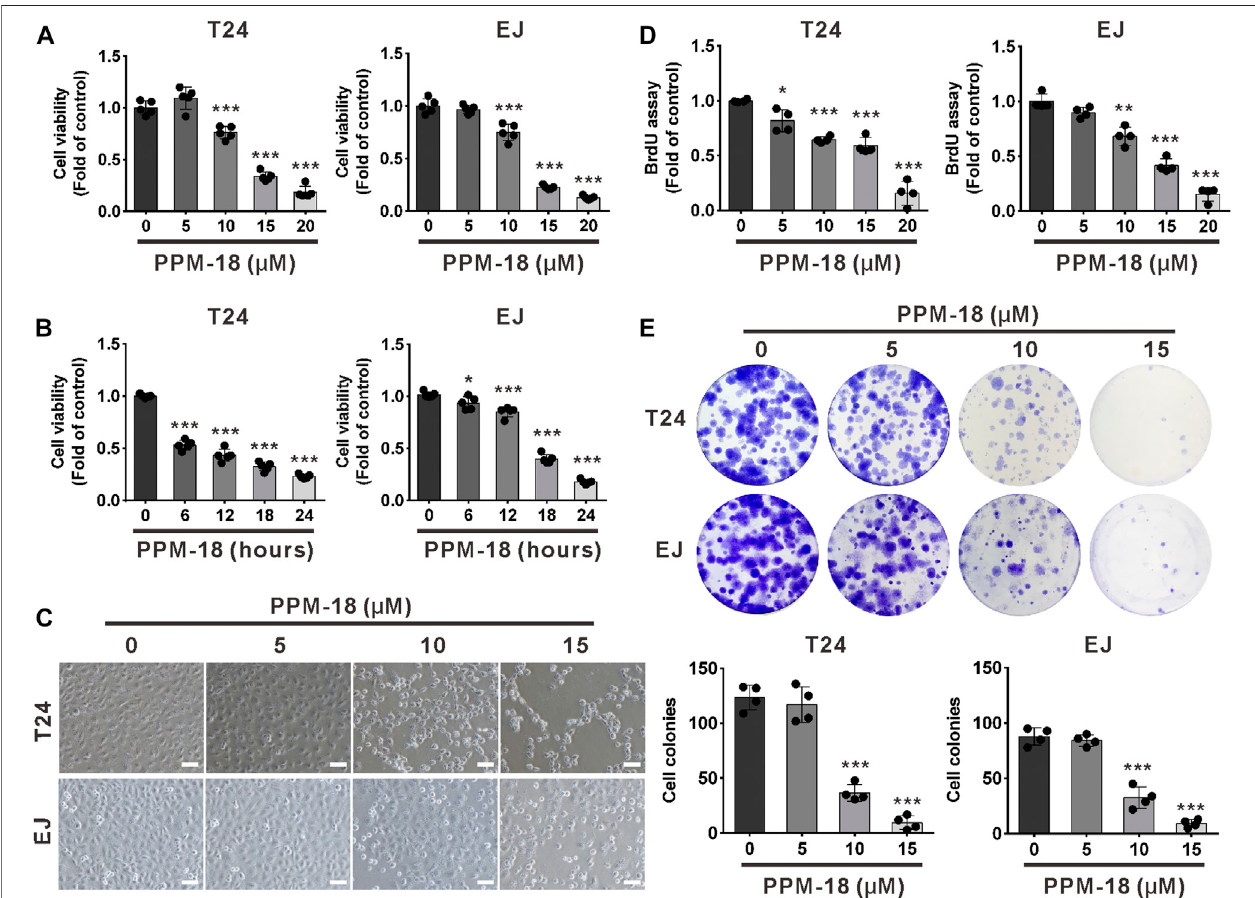
FIGURE1| PPM-18inhibitsthegrowthofbladdercancercells. (A) BladdercancerT24andEJcellsweredose-dependentlytreatedwithPPM-18for24 h,andthe cell viability wasassessed by theMTS assay. (B) The effect of15 μ M PPM-18 on the viabilityof T24and EJ cells in atime-dependent manner. (C) T24and EJ cells were treated with the indicated concentration of PPM-18 for 24 h, and the morphological changes of cells were observed under the microscope. Scale bar: 100 µm. ( D) The effectofPPM-18ontheproliferationofT24andEJcellswasdeterminedbytheBrdUassay. (E) PPM-18dose-dependentlyaffectedthecellularcolonyformationof T24 and EJ cells. Data are presented as the mean ± SD of at least three independent experiments. * p < 0.05, ** p < 0.01, and *** p < 0.001 vs. the control group.